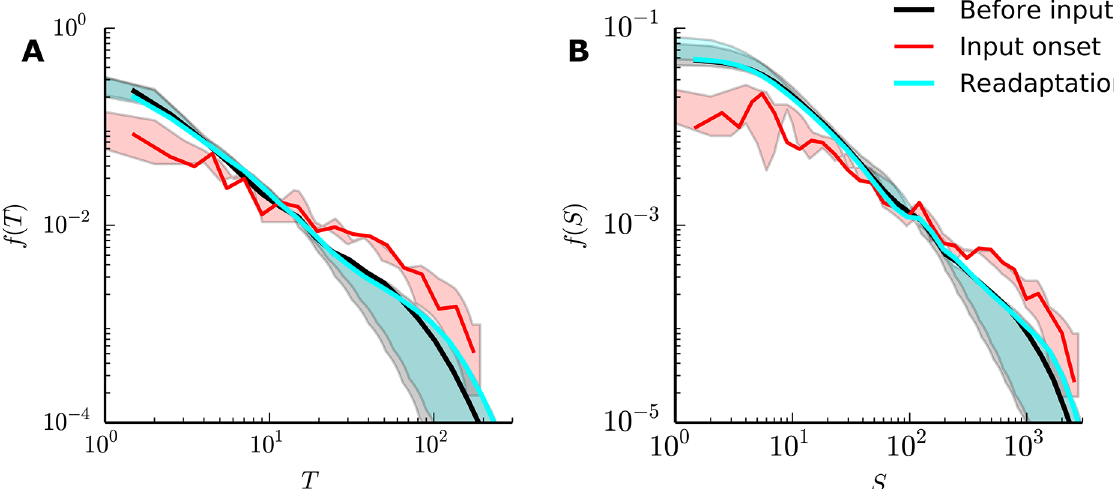
Fig 6. SORN readaptation under external input. (A), (B) Durationand size distributions, respectively, after externalinput onset: transient readaptation period (red) and remaining2 × 10 6 time steps (cyan). Before input and Readaptation curves show combined data from 50 independent simulations. Input onset curves show data from 250 input onset trials, and shadedregions show the effects of variationsin the activity threshold ( θ betweenthe 5th and 25th percentilesof the activity distribution).